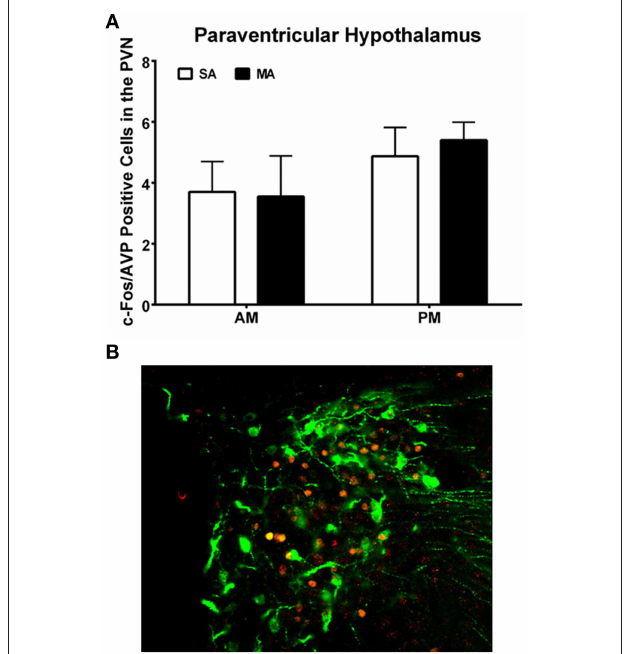
FIGURE 6 | (A) Similar c-Fos/AVP dual-labeling in the PVN following MA exposure in the AM and PM. Mice treated with MA in the day and night showed no increase in c-Fos/AVP-ir cells in the PVN compared to saline-treated mice. n = 10 mice/treatment/time period. (B) Representative panel of c-Fos (red) and AVP (green) from a mouse treated with MA in the AM is shown.